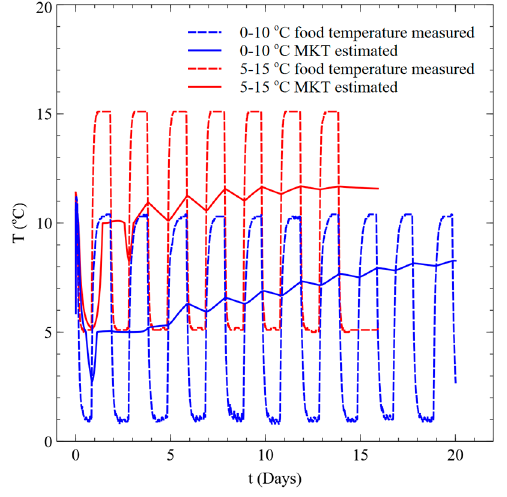
Figure 8. Measured temperature vs. estimated mean kinetic temperature.